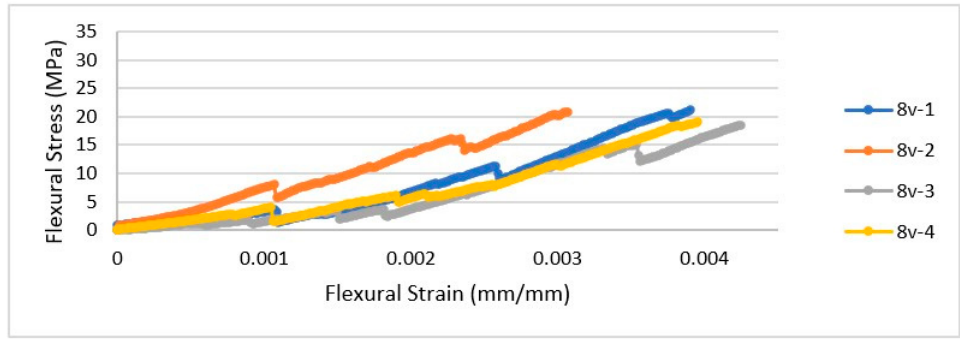
Figure 9. Flexural stress–strain curves of the specimens of batch 8v.